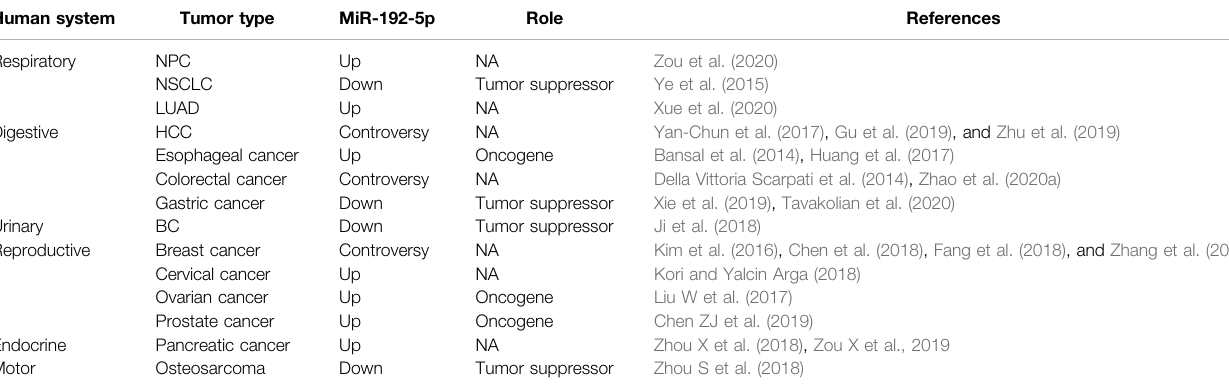
TABLE 2 | the expression and role of miR-192-5p in different human cancers. NA, not available. Human